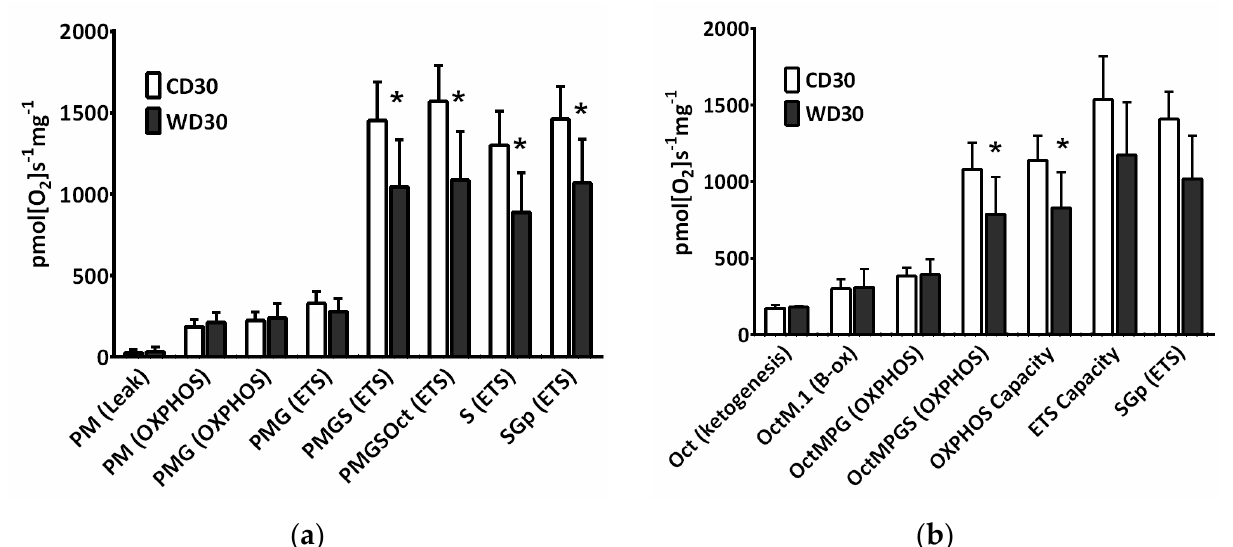
Figure 3. Mitochondrial respiration in mice fed a control diet (CD30) or a Western ‐ style diet (WD30) for 30 weeks. ( a ) Respiratory protocol 1. ( b ) Respiratory protocol 2. Liver homogenates were loaded at a protein concentration of 0.15 mg/mL, and substrates, uncoupler, and inhibitors were gradually added according to the protocol: P (pyruvate, 5 mM), M (malate, 2 mM), M.1 (malate, 0.1 mM), G (glutamate, 10 mM), S (succinate, 50 mM), Oct (octanoylcarnitine, 0.5 mM), and Gp (glycerophosphate, 10 mM). The LEAK state was measured in the presence of reducing substrates but in the ab ‐ sence of ADP. The oxidative phosphorylation (OXPHOS) state was measured in the presence of saturating concentrations of ADP (2.5 mM) and defined reduced substrates. The electron transfer system (ETS) state was measured as oxygen con ‐ sumption in the noncoupled state at the optimum uncoupler concentration (carbonyl cyanide 4 ‐ (trifluoromethoxy)phe ‐ nylhydrazone, 1.5 ‐ 2 μ M), which was obtained by stepwise titration to induce maximum oxygen flux. Capacity indicates respiration in the presence of all substrates. To inhibit NADH ‐ dependent substrate respiration, rotenone (0.5 μ M) was added. Data were corrected for residual oxygen consumption (ROX) as the baseline state. ROX is respiration due to oxi ‐ dative side reactions that continue after inhibition of the ET pathway (antimycin A, 2.5 μ M). Outer mitochondrial mem ‐ brane integrity was assessed by the addition of cytochrome c (10 μ M). Results are expressed as the means ± SD; * p < 0.05